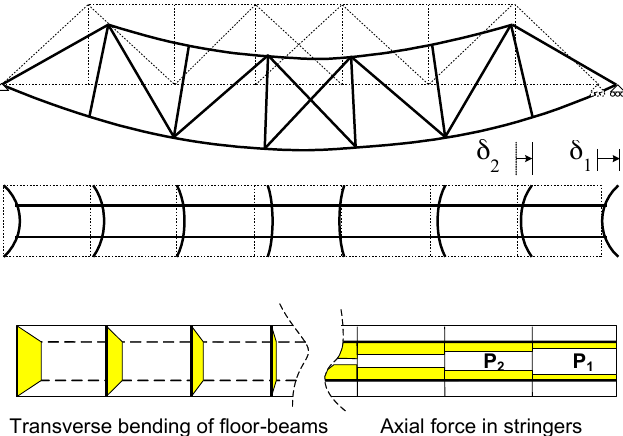
Figure 16. The interaction between the floor system (stringers and floor beams) and the main bridge trusses results in secondary axial forces and bending moment in the stringers and the floor beams,